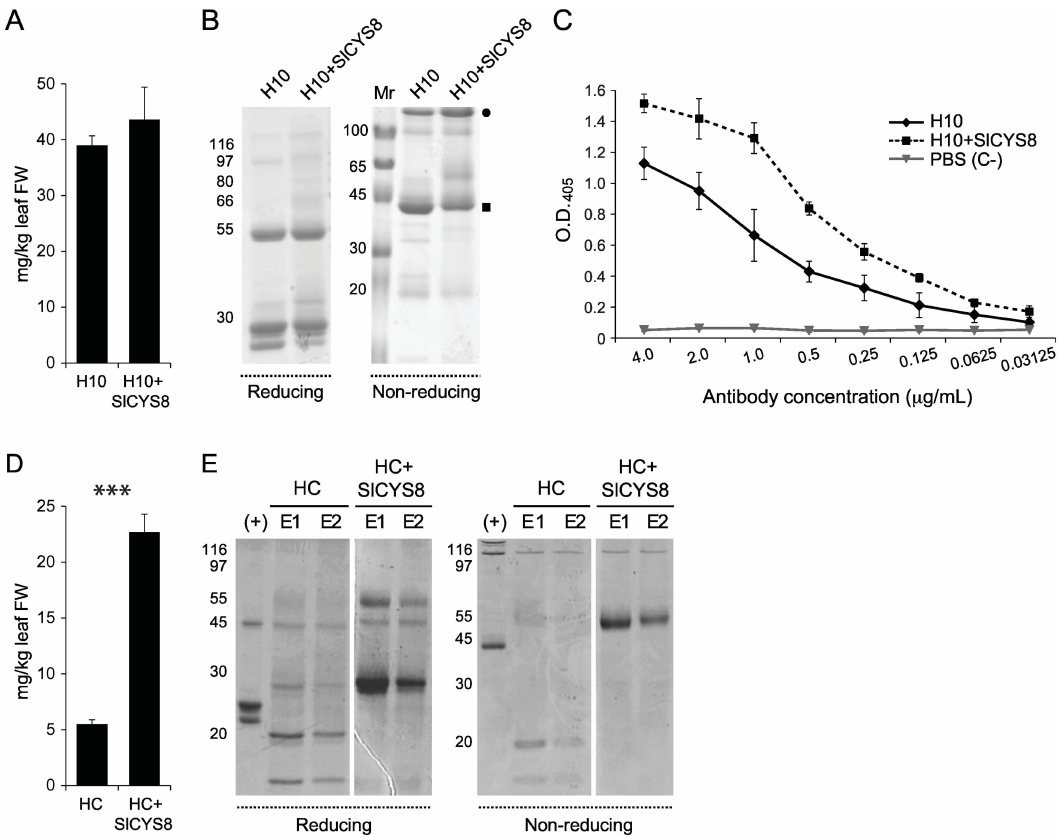
Fig 6. Protein A-based affinity purification of H10 full size antibody and heavy chain fragments from leaf protein extractsof control and Sl CYS8-expressing plants. A: Purification yield of H10 protein products expressedalone or along with Sl CYS8. Average yields ( ± SE ) were calculatedfrom three independentpurification rounds. B: Coomassie blue staining of purifiedfull size H10 and H10 fragmentsfollowingSDS-PAGE in reducingor non-reducing conditions. The closed circle points to full size H10, the closed square to a stable heavy chain-containing fragment. C: Antigen-binding activity of purifiedH10. The purifiedantibodieswere added to TNC-coated plates at serial dilutionsstarting from 4 μ g/ml. Data are the mean of three independent experiments ± SD . PBS (C–), negative control. (D) Purificationyield of H10 heavy chain expressedalone or together with Sl CYS8.Average yields ( ± SE ) were calculatedfrom three independentpurification rounds. Asterisks indicatea highly significantdifference betweenthe two purificationyields (Student’s t-test; P < 0.001). (E) Coomassie blue staining of purifiedH10 fragments followingSDS-PAGE in reducing or non-reducing conditions. E1 and E2 show two elutionfractions duringprotein A chromatography. (+), purifiedH10 used as a reference. On panels B and E, numbers on the left correspond to molecularmass markers